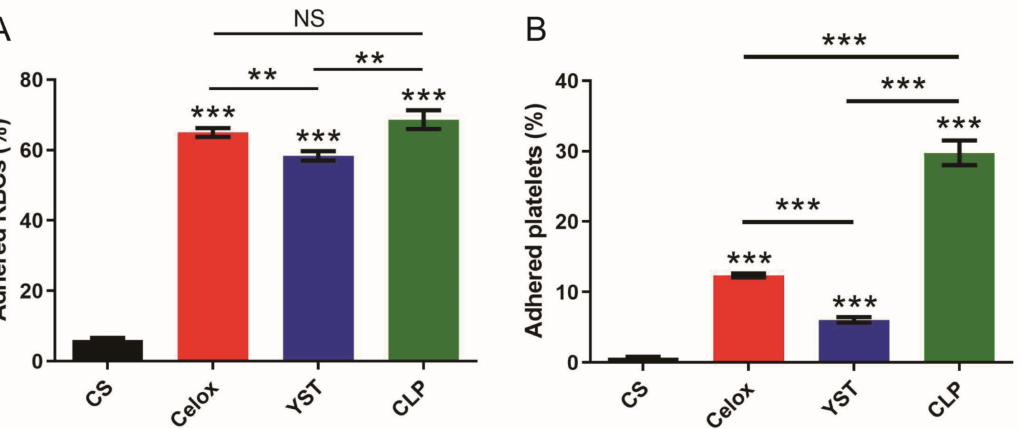
Figure 4. In vitro procoagulability of CLP. Ratio of adhered ( A ) RBCs and ( B ) platelets ( n = 6). Values represent means ± SEM. The differences between each group were performed using two-tailed unpaired t -test. The ‘NS’ indicated no significant difference, ** p < 0.01, and *** p <